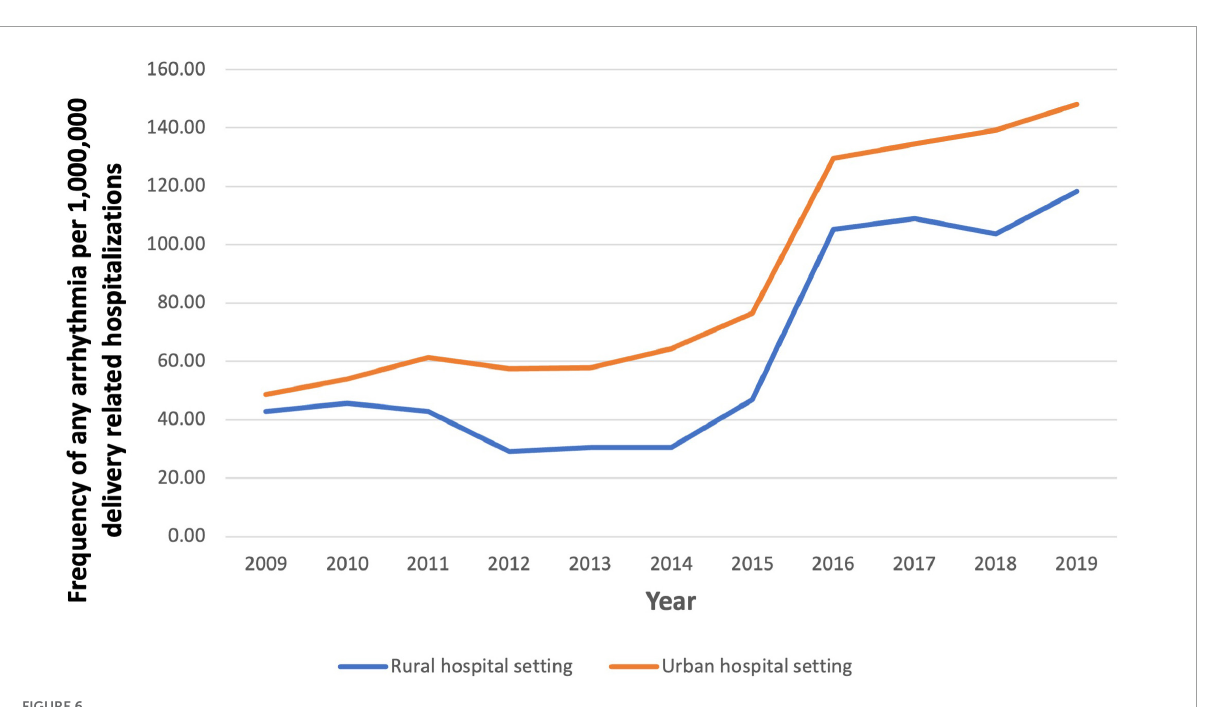
higher prevalence of various APOs: preeclampsia (6.96%